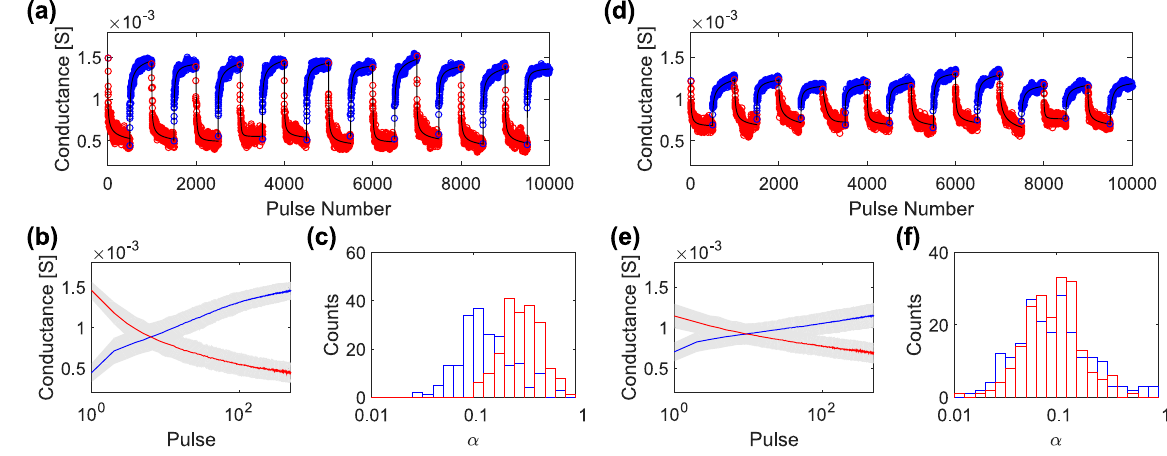
Figure 6. ( a , d ) First ten of 200 cycles programmed with 500 identical pulses of alternating depression and potentiation operations. Δ V and Δ t are + 0.9 V/ − 0.7 V, 10 μ s in ( a ) and + 0.75 V/ − 0.6 V, 100 ns in ( d ). In black line, fit to data of the generalized soft bound model. ( b , e ) Evolution of the average conductance (straight line) and associated standard deviation (in grey) against the number of pulses for the two data sets in ( a , d ). ( c , f ) Distributions of the α parameter extracted from